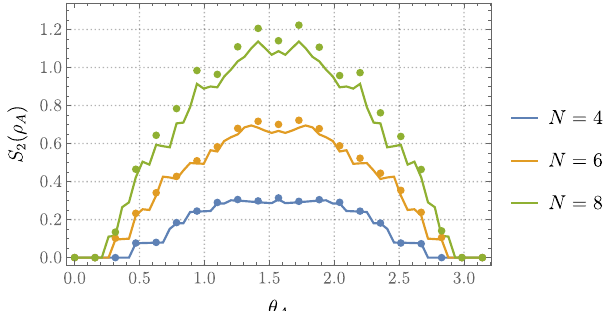
FIG. 11. The second R´enyi entropy for a spherical cap on the matrix theory fuzzy sphere versus the polar angle θ Solid curves are exact values at ν ¼ ∞ , and dots are numerical values from variational wave functions at ν ¼ 10 for different N . The wave functions are NF(1, 1) in the zero fermion sector as shown in Figs. 2 and